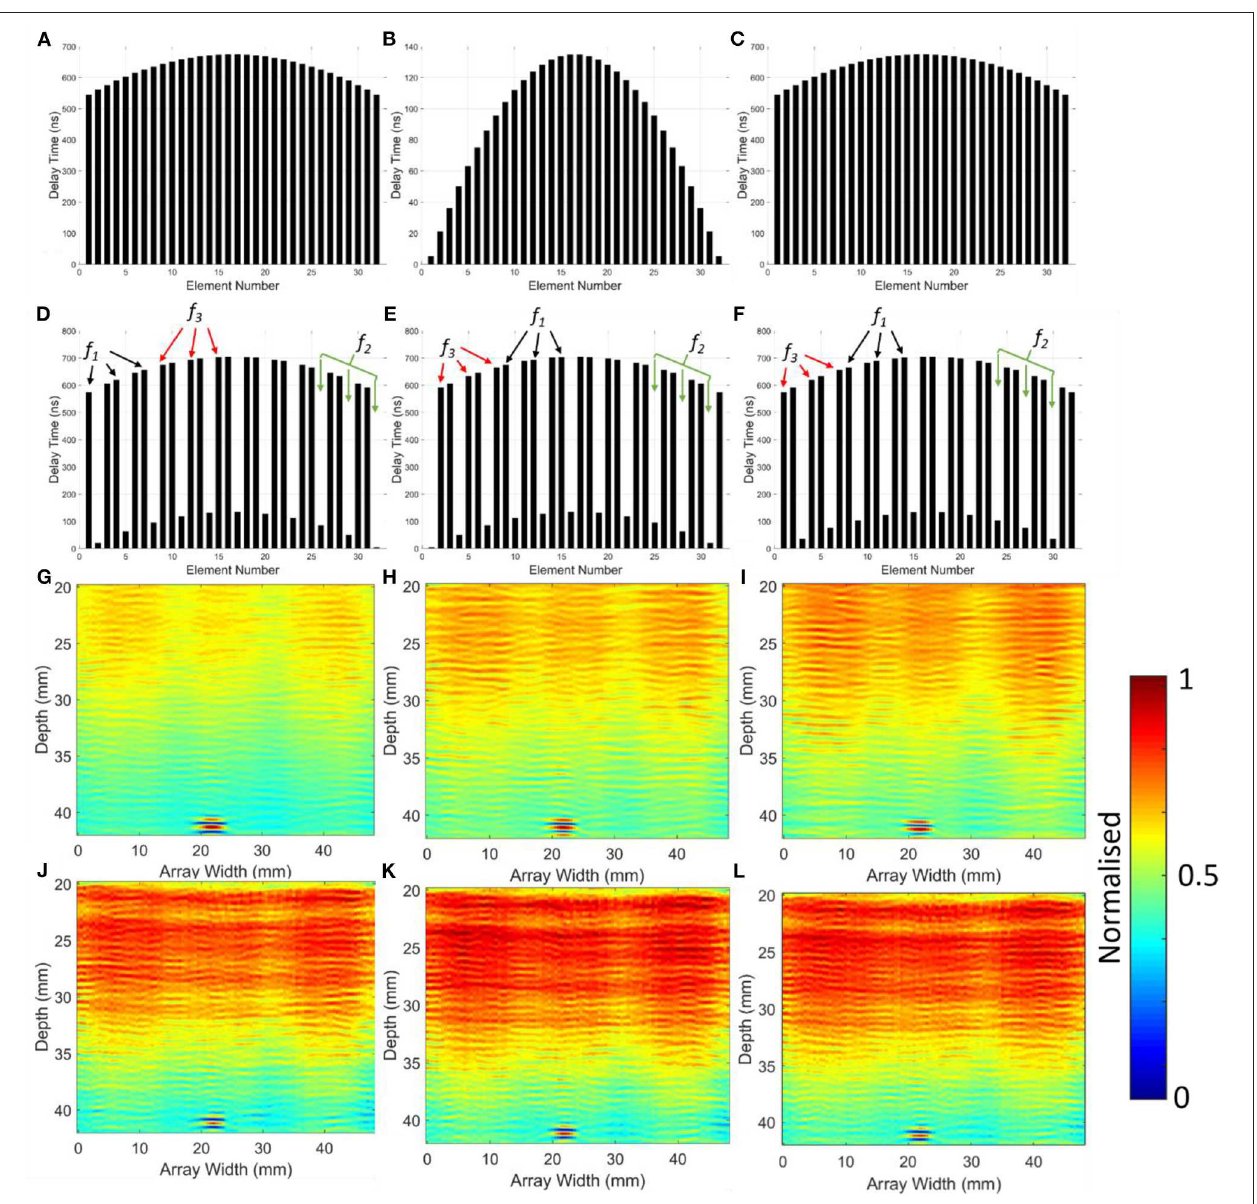
FIGURE 3 | Delay laws for tri frequency modulation for 32 elements using a stepped/sequential firing method: (A) f 1 ; (B) f 2 ; (C) f 3 ; (D) f 123 ; (E) f 231 ; (F) f 312 , and raw B-Scan images for: (G) f 1 ; (H) f 2 ; (I) f 3 ; (J) f 123 ; (K) f 231 ; (L) f 312